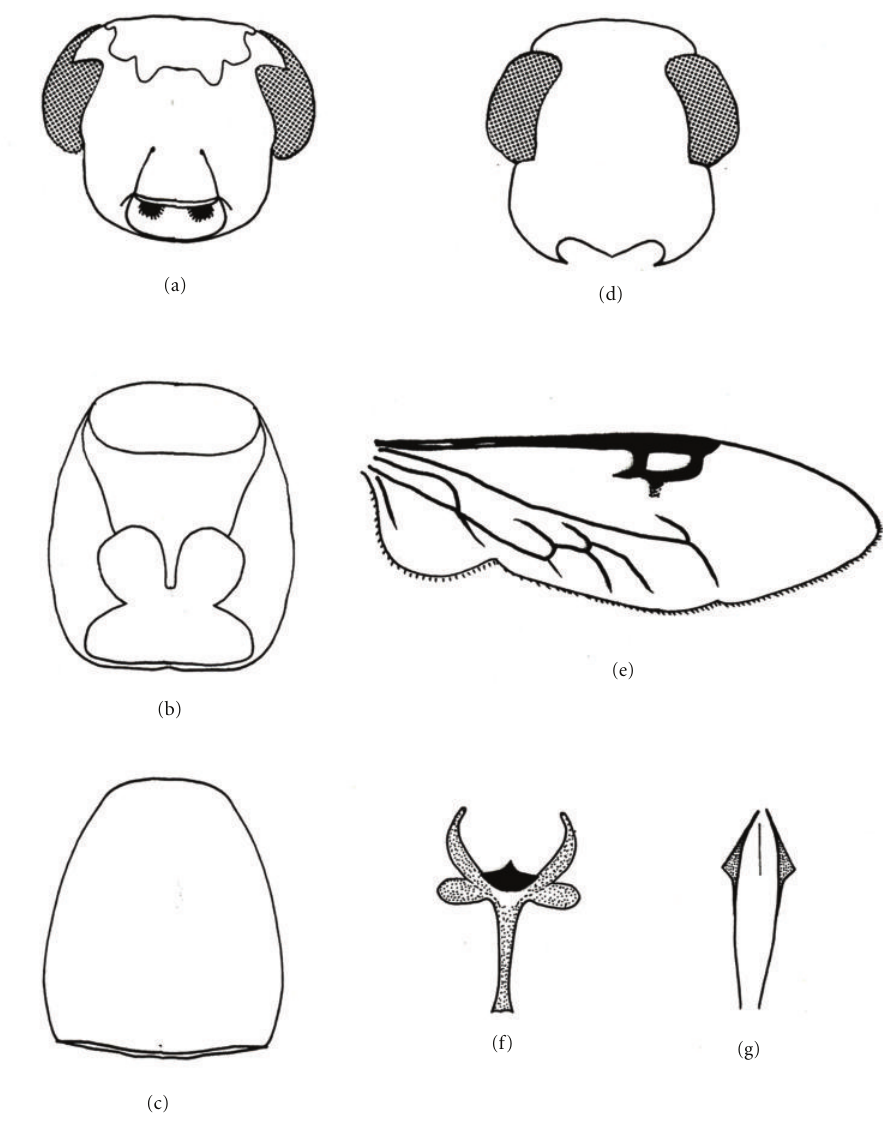
Figure 14: Various organs of Rhophaloclerus coquerelii . (a) Head (ventral). (b, c) Pronotum ((b) ventral, (c) dorsal). (d) Head (dorsal). (e) Metathoracic wing. (f) Metendosternite. (g)